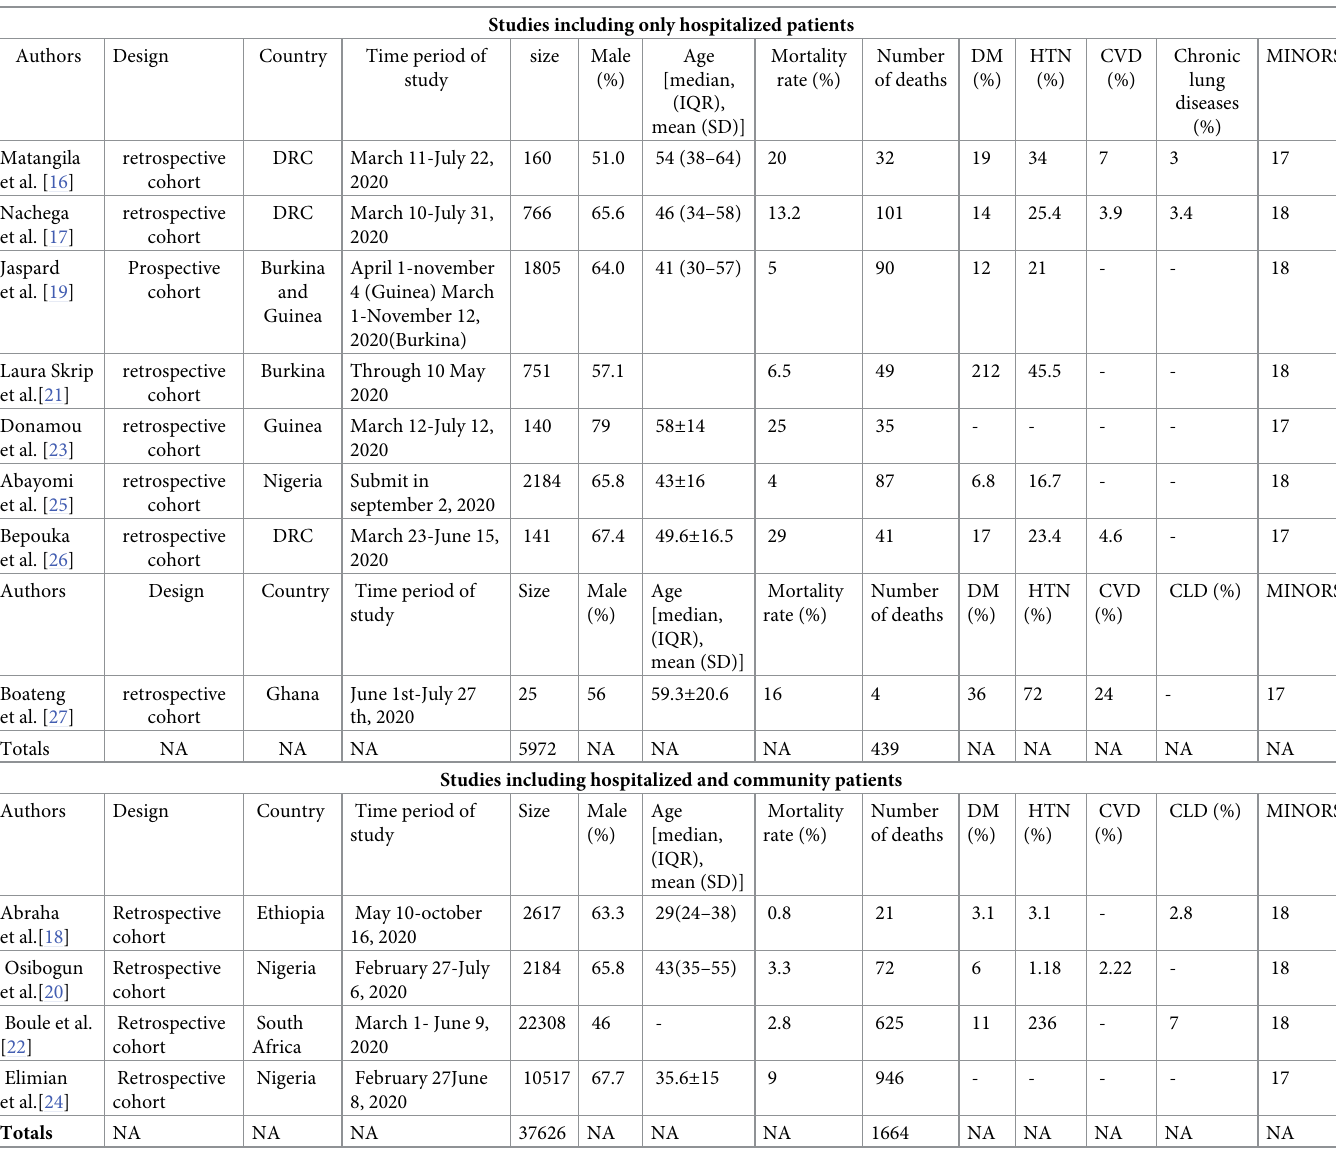
Table 1. Characteristics of the included